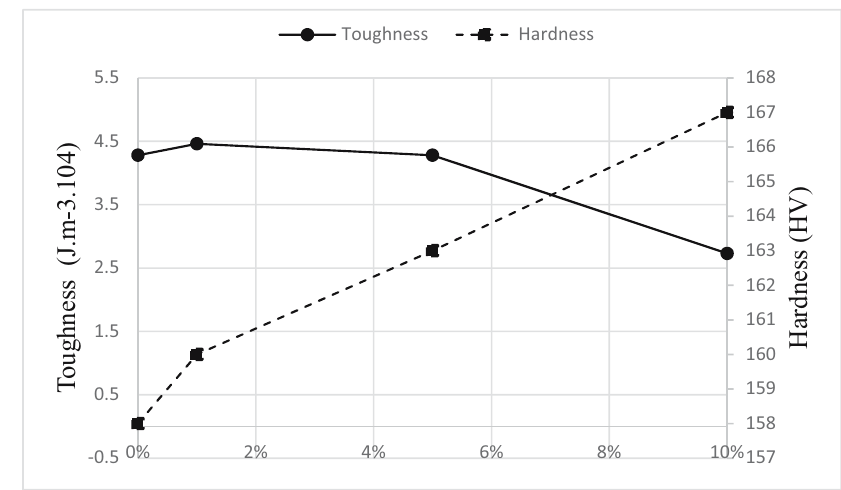
Figure 8: Variations of toughness and hardness vs alumina